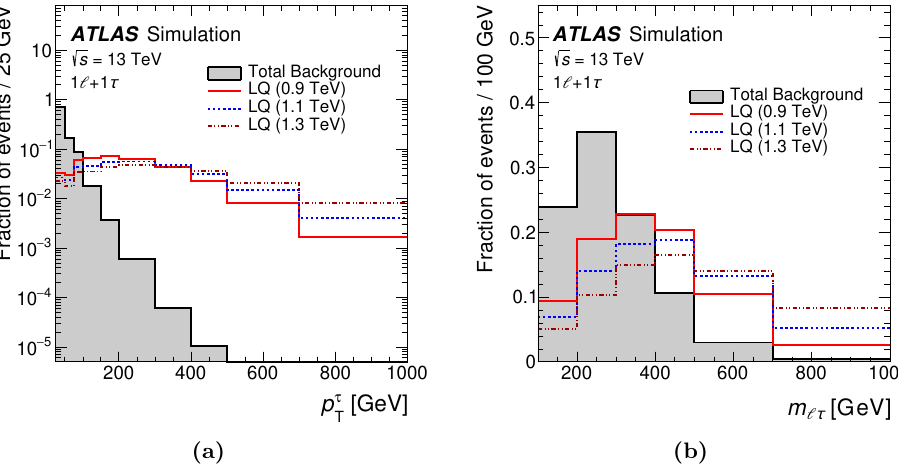
), and (b) the T candidate ( m ), between the total background had ‘τ